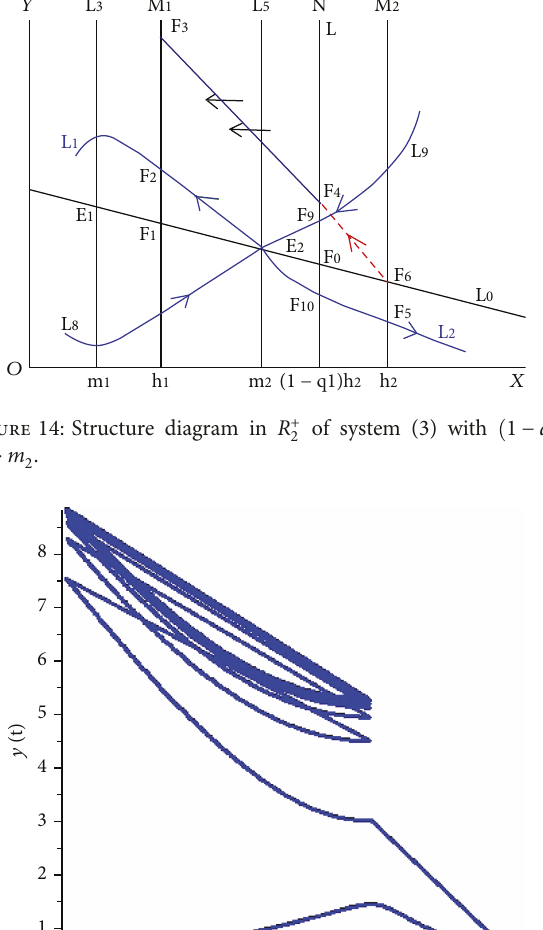
Figure 15: There exists an order-1 periodic solution in system (16) with q 1 = 1/9 , p = 0 4 , and τ = 2 7 .